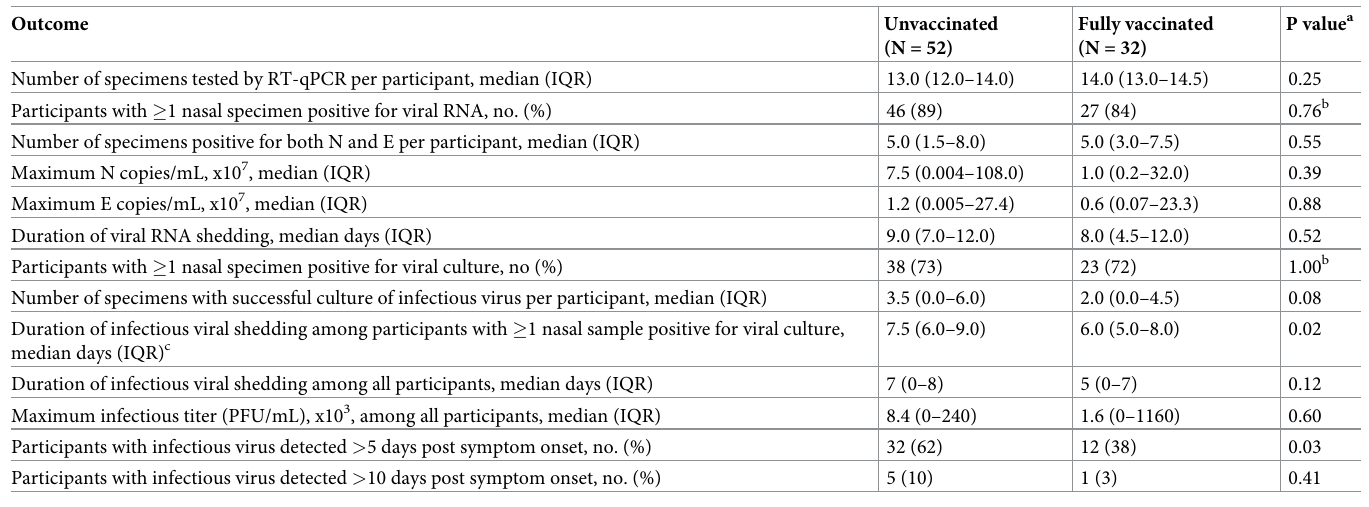
Table 2. Viral shedding outcomes for adult participants, by vaccination